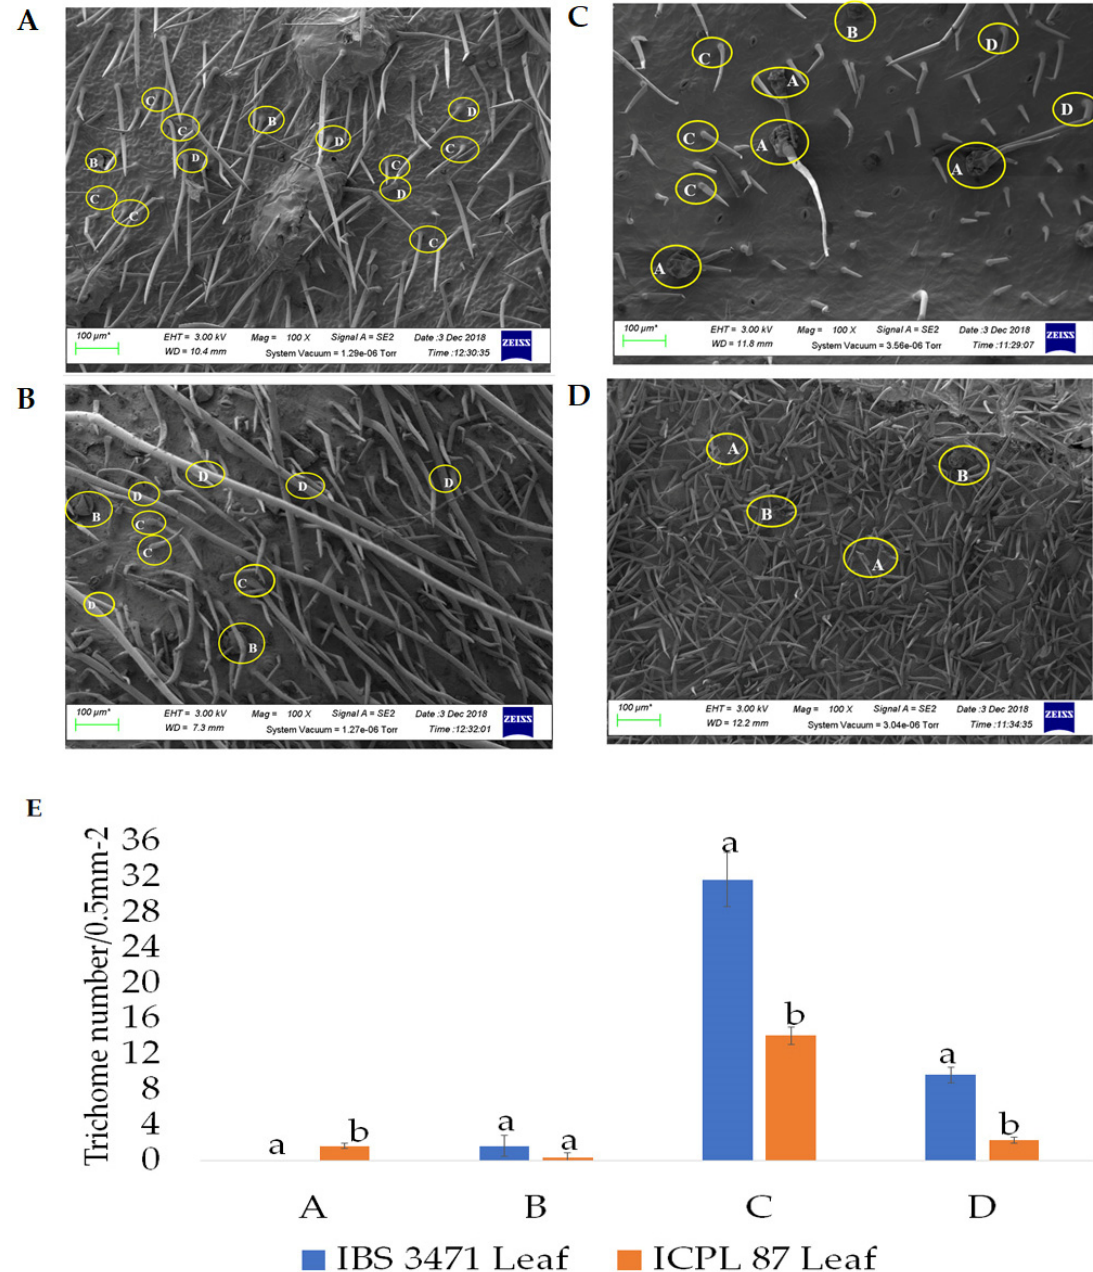
Figure 2. Scanning electron micrographs of di ff erent trichome types for IBS 3471 and ICPL 87 at 100X magnification. ( A ) IBS 3471 leaf, ( B ) IBS 3471 pod, ( C ) ICPL 87 leaf, ( D ) ICPL 87 pod and ( E ) leaf Table trichome number per 0.5 mm 2 for IBS 3471 and ICPL 87. The di ff erent trichome types are identified with letters in yellow circles. All scale bars are 100 µ m. Values labelled with di ff erent letters are significantly di ff erent at p < 0.05 ( t -test). All data are means ± standard errors ( n = 3).